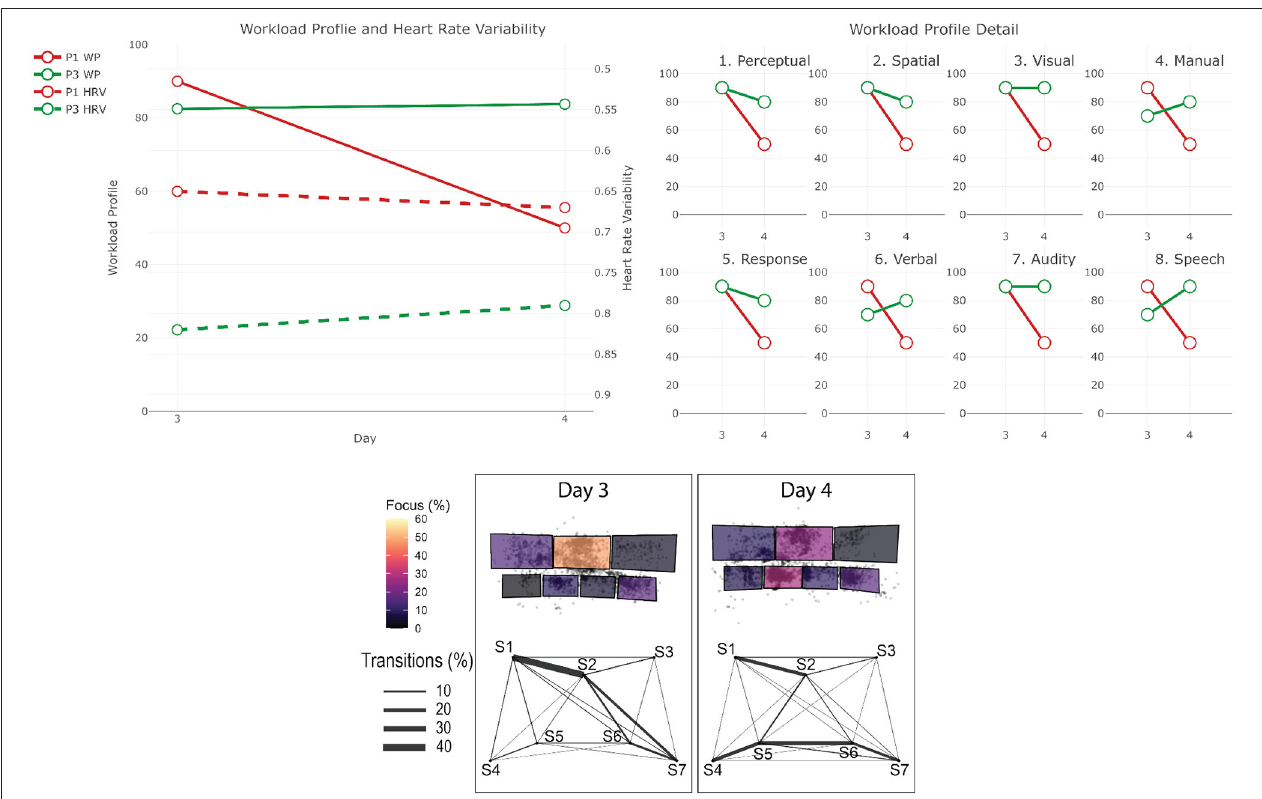
FIGURE 8 | Results for the two handover sessions. The top-left chart shows the evolution of the WP and HRV during the session for both participants (the axis of the HRV is inverted). The top-right chart shows the evolution of each criteria of the WP during the session for both participants. The bottom chart displays eye tracking data for P3 for each phase: at the top is the schematic representation of the operator’s workspace with a heatmap showing the amount of time the operator spent focusing on each screen; the bottom graph indicates the amount of transition between each of the screens with the thickness of the lines. The same organization is used in the following